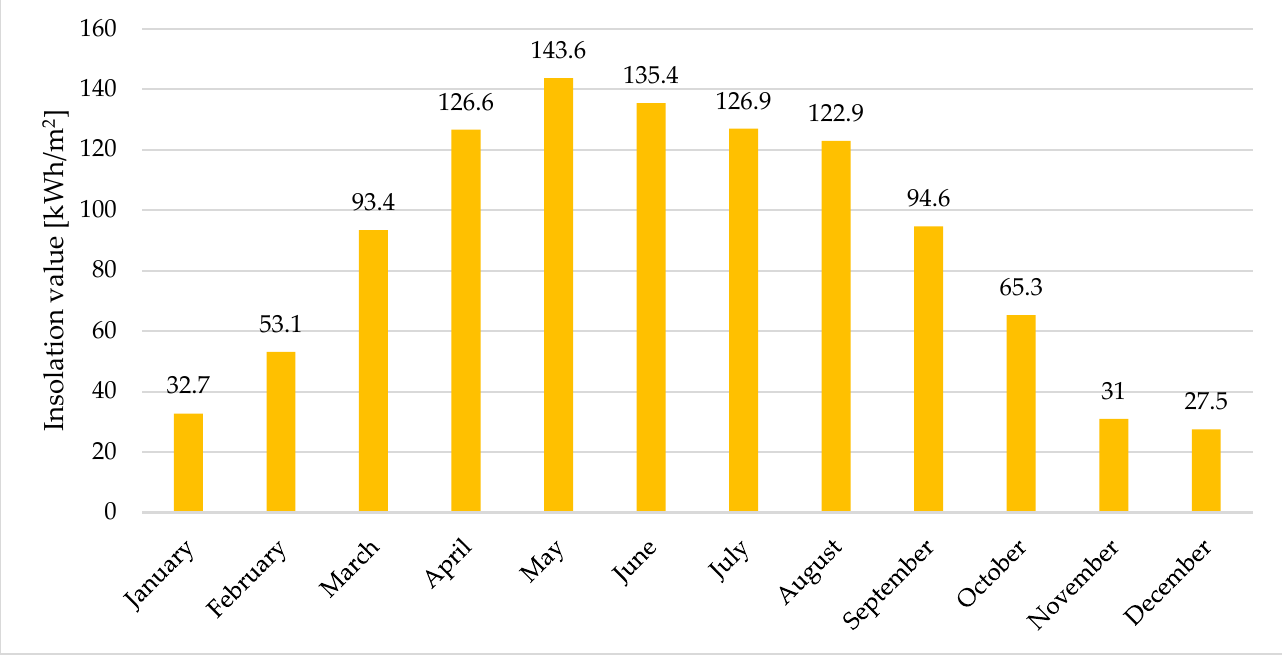
Figure 2. Distribution of insolation over the year for the indicated location.